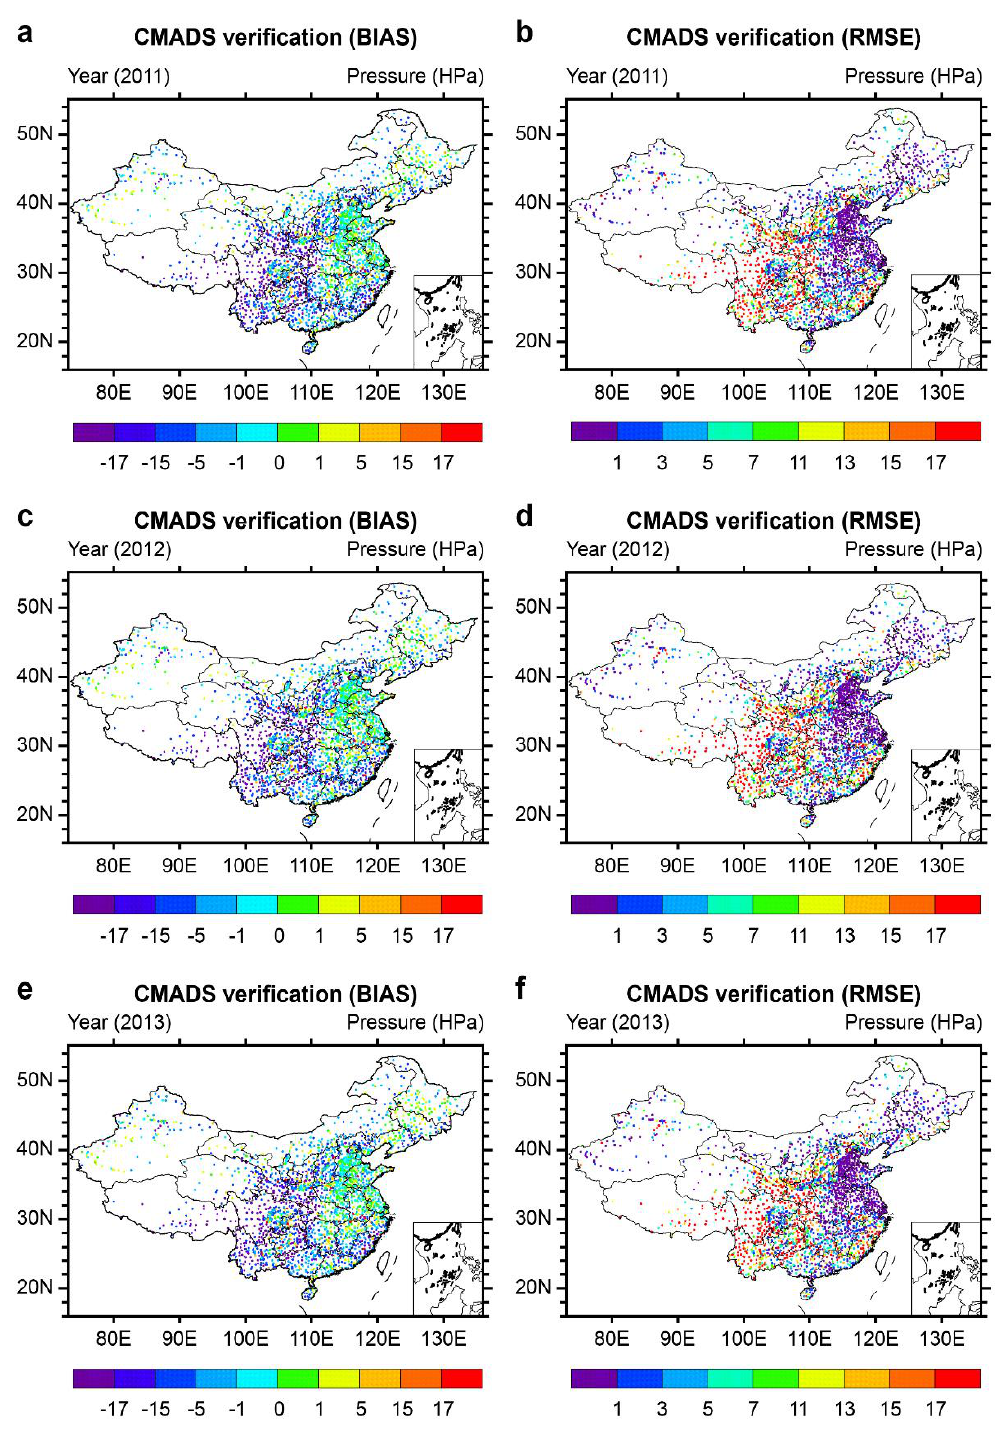
Figure 5. The evaluation of indicators for atmospheric pressure in China (2011–2013). ( a ) The spatial distributions of the biases for the atmospheric pressure in year 2011, ( b ) The spatial distributions of the RMSEs for the atmospheric pressure in year 2011, ( c ) The spatial distributions of the biases for the atmospheric pressure in year 2012, ( d ) The spatial distributions of the RMSEs for the atmospheric pressure in year 2012, ( e ) The spatial distributions of the biases for the atmospheric pressure in year 2013, ( f ) The spatial distributions of the RMSEs for the atmospheric pressure in year 2013.